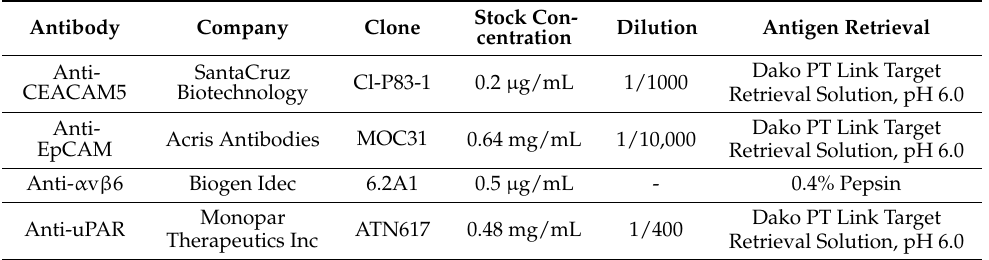
Table A1. Primary antibodies used.